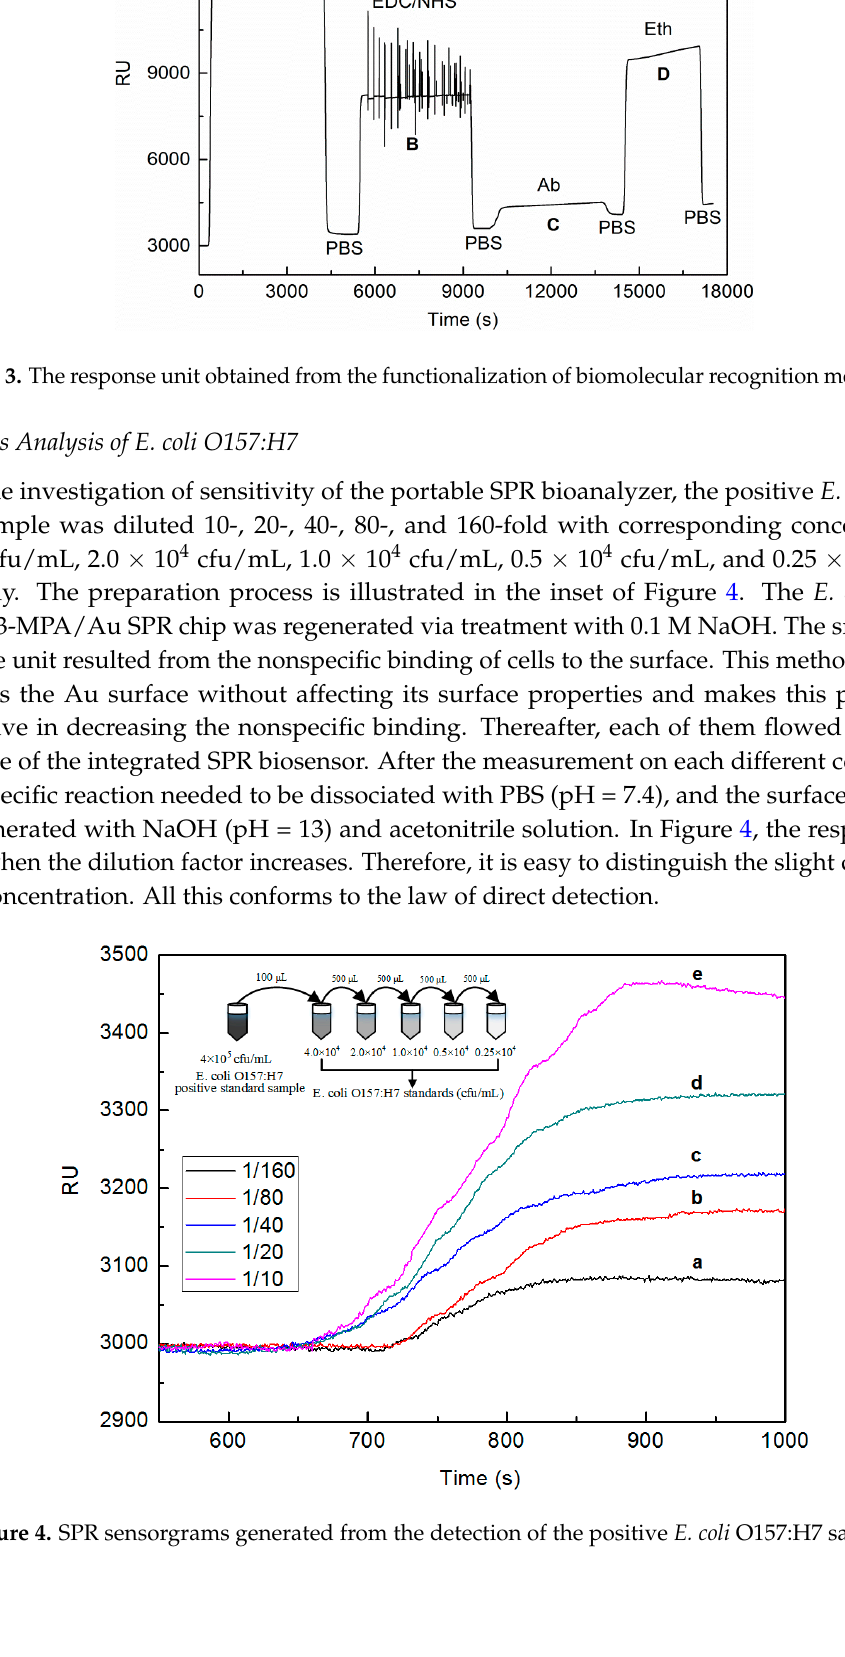
Figure 5. The relationship between different concentrations of E. coli O157:H7 and the SPR response signals.